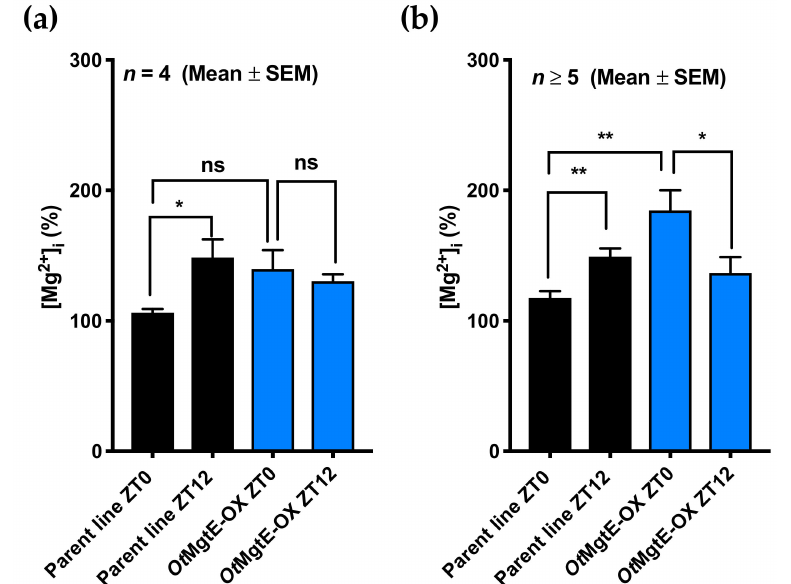
Figure 2. Overexpression of OtMgtE increases [Mg 2+ ] i at ZT0. Quantification of [Mg 2+ ] i by inductively coupled plasma mass spectrometry (ICP-MS) ( a ) or luciferase-based plate assays ( b ). A significant increase in [Mg 2+ ] i at dusk compared to dawn is observed in the parent line, and OtMgtE overexpression leads to an increase in [Mg 2+ ] i at ZT0. Non-significant (ns) = p > 0.05; * = p < 0.05; ** = p < 0.001; student’s t